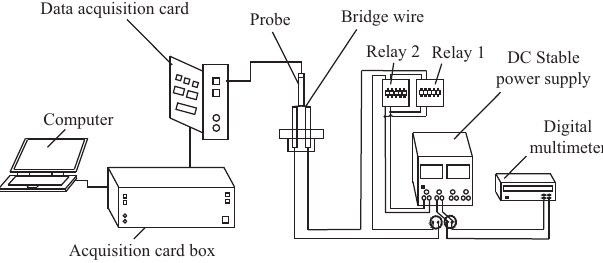
Figure 4: Schematic diagram of the bridge wire temperature increase test system. Table 2: Test results of bridge wire temperature increase at ambient temperature of 25.6 ° C. Injection current (mA)